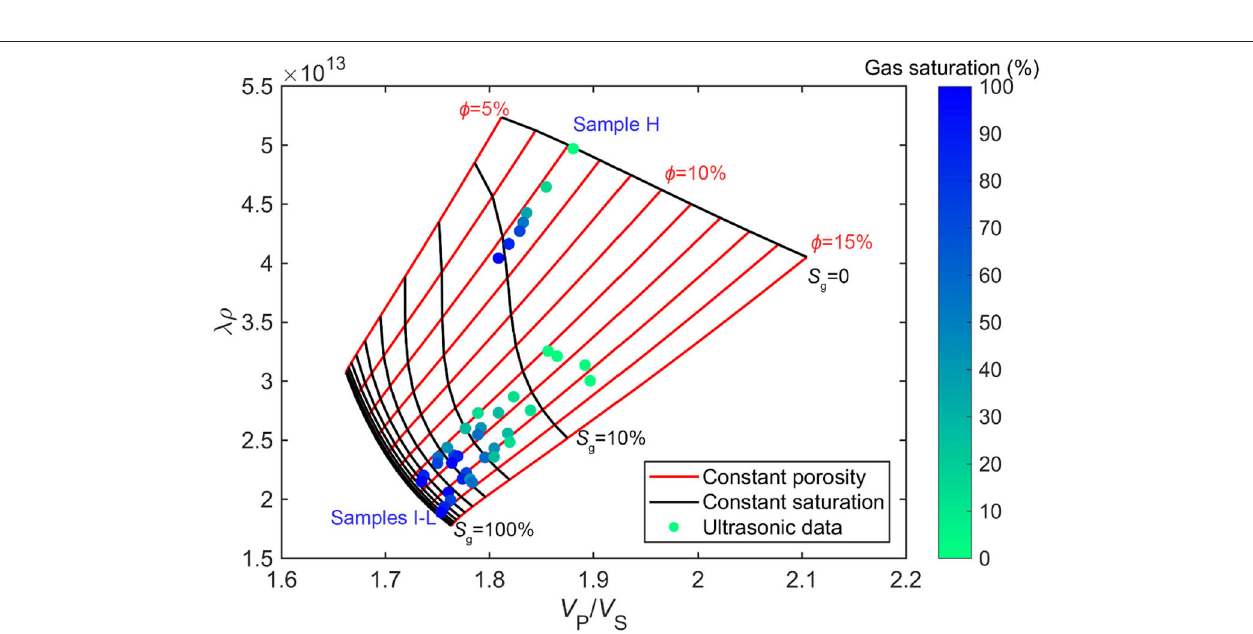
FIGURE 8 | Comparisons between the ultrasonic template and measured data for siltstones.